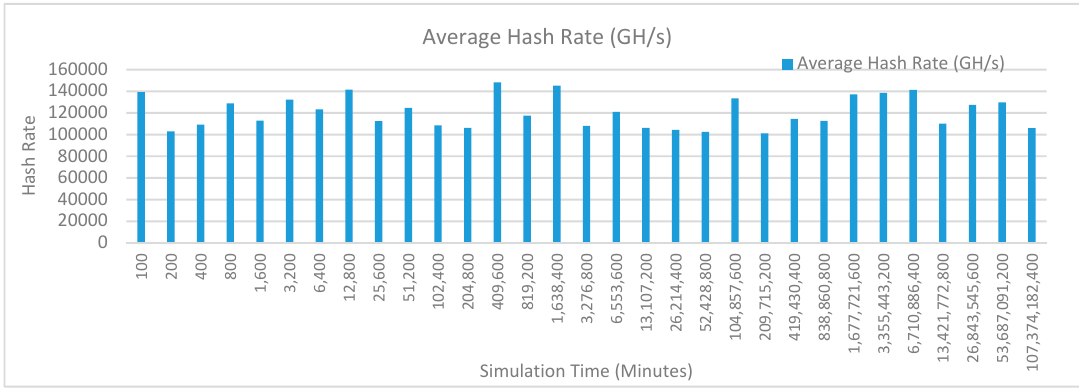
Figure 16. Average hash rate analysis (with IoT, edge, fog).